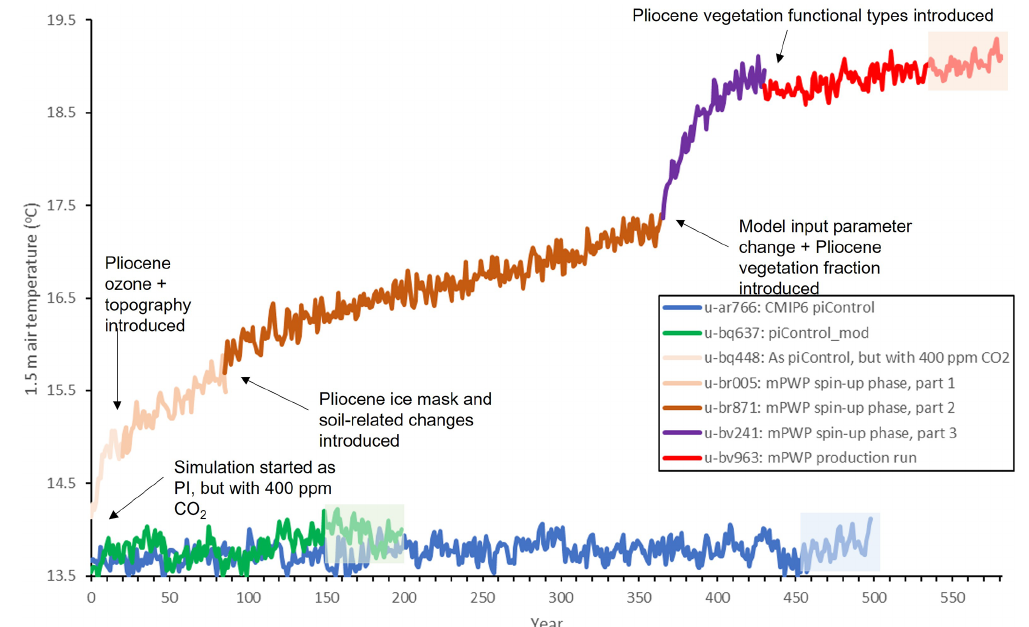
Figure 6. Annual global mean 1.5m air temperature from the HadGEM3 mPWP spin-up phase and production run, as well as the CMIP6 piControl and the piControl_mod . Labels show introduction of each new Pliocene element. Climatologies discussed here are taken from final 50 years of each simulation (shown by shaded boxes). See Williams et al. (2020b) for the piControl spin-up phase that preceded these